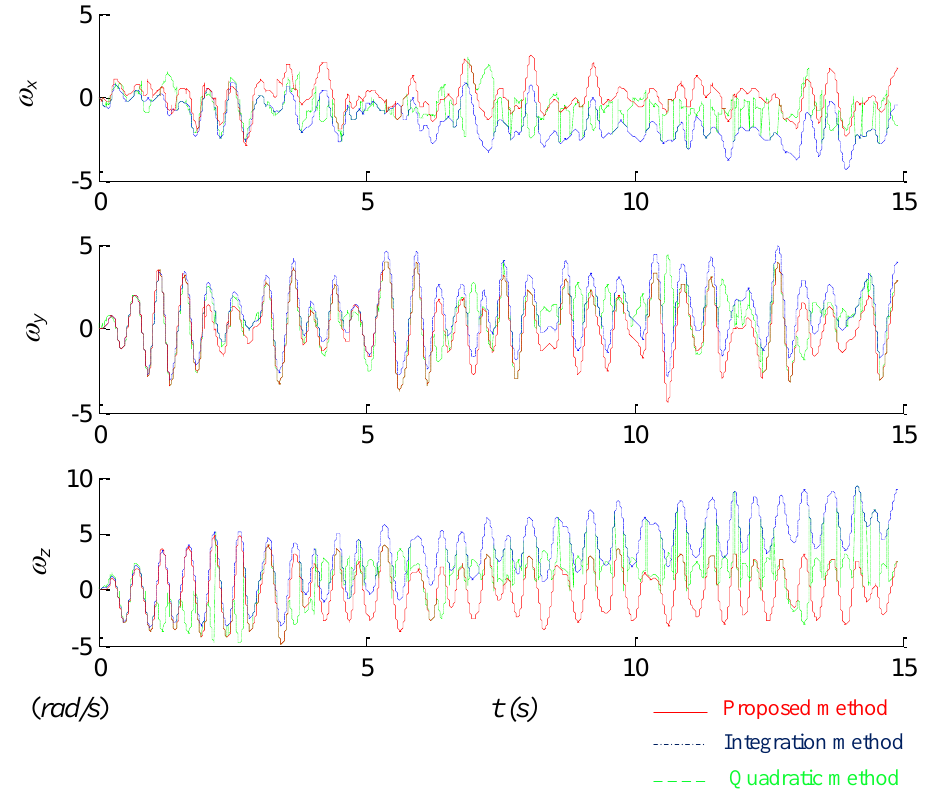
Figure 11. Comparison of the angular velocity derived from three different methods: integration method (blue dash-dotted line)), quadratic method (green dashed line), and proposed method (red solid